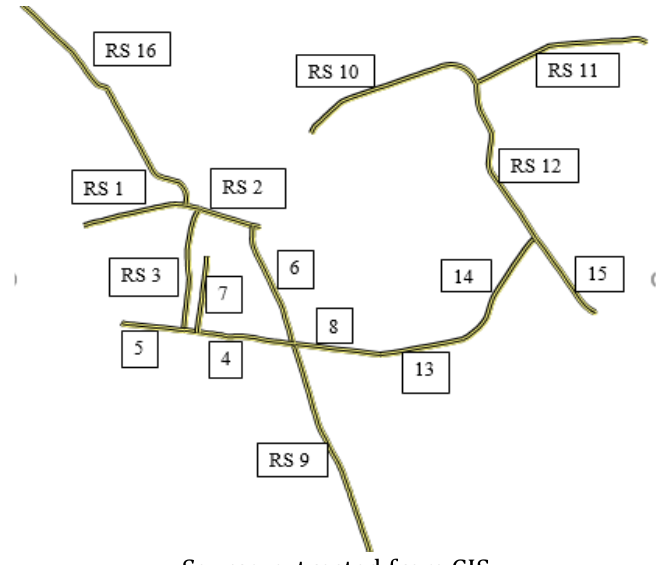
Figure 2: Selected road segments with their codes